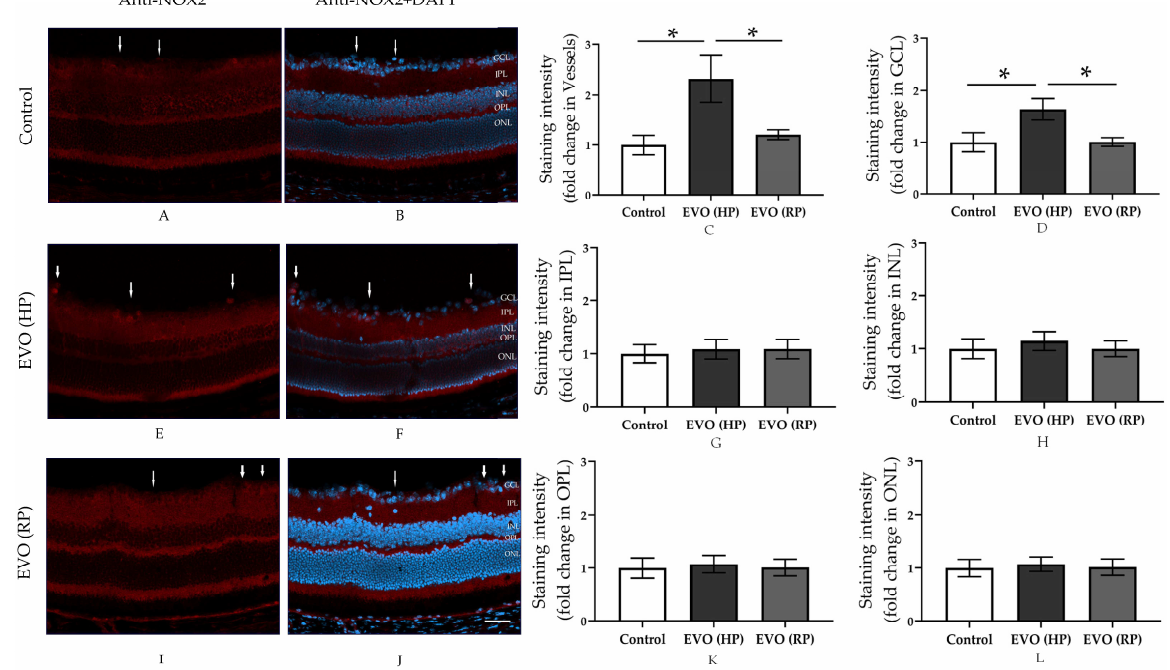
Figure 4. Immunostaing of anti-NOX2 and quantitative analysis of its fluorescence intensity in retinal cryosections. The anti-NOX2 stained retinal cryosections from Control group ( A , B ), EVO (HP) group ( E , F ) and EVO (RP) group ( I , J ). ( C ), ( D ), ( G ), ( H ), ( K ) and ( L ) show the staining intensity quantified from vessels, GCL, IPL, INL, OPL and ONL respectively. The white arrows point to retinal blood vessels. GCL: ganglion cell layer; IPL: inner plexiform layer; INL: inner nuclear layer; OPL: outer plexiform layer; ONL: outer nuclear layer. EVO: episcleral vein occlusion; HP: high intraocular pressure; RP: recovered intraocular pressure. Control group refers to sham group. Values are expressed as mean ± SEM (* p < 0.05; n = 6 per group, scale bar = 50 μm). 3.5. Elevated IOP Reversibly Increased the Expression of Messenger RNA of NOX2 and TNF-α High IOP increased mRNA expression for the prooxidant gene, NOX2 , and for the proinflammatory cytokine, TNF-α , two weeks after IOP elevation, as shown in the EVO (HP) group; the levels increased 5.9-fold ( * p < 0.05) and 4.2-fold ( ** p < 0.01), respectively, compared to controls (Figure 5). However, these increased values dropped to control lev- els four weeks after IOP normalization in the EVO (RP) group (Figure 5).